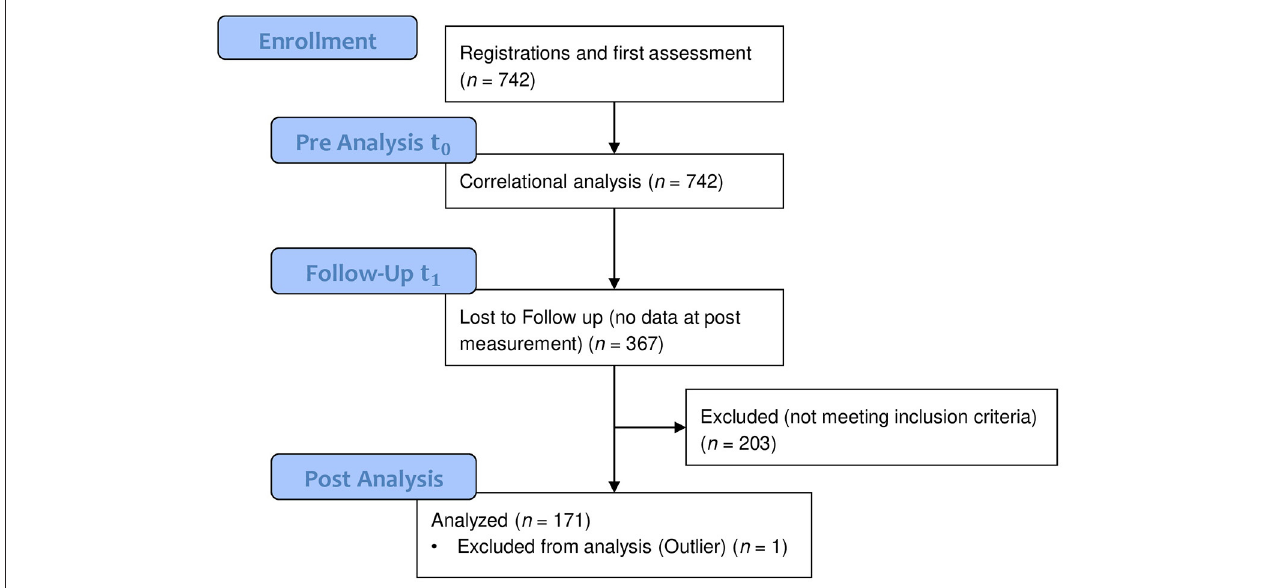
FIGURE 1 | Phases of data assessment and